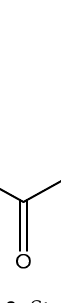
Figure 4. An illustration of the magnesium bis -orotate octahydrate reported by Schmidbaur et al. [84]. The pictorial representation is devoid of the two additional outer-sphere waters reported. As illustrated, the complexed orotic acid does not coordinate to magnesium as a traditional chelate. In fact, the orotic acid forms a complex with magnesium via outer-sphere coordination as a result of an extensive hydrogen bonding network—most notably, the interaction between the deprotonated terminal carboxylic acid and the ubiquitous hexaaquo magnesium core described by Weston [40]. Schmidbaur goes on to elaborate that there was no evidence to support that orotic acid would replace water within the inner sphere of the magnesium and subsequently stated that magnesium bis- orotate tetrahydrate, if bought commercially, would form the described octahydrate in aqueous solution at ambient temperature [84]. Similar findings were produced by Schmidbaur after the synthesis of magnesium bis- anthranalite dehydrate [89]. Schmidbaur further spoke to a similar form of outer-sphere coordination exhibited by citric acid as was initially described by Johnson et al. [90]. Schmidbaur went on to further evaluate the coordination of mandelic acid (mandelate— International Union of Pure and Applied Chemistry (IUPAC): hydroxyl (phenyl) acetic acid), a similar aromatic organic compound (Figure 5) [86,87] to magnesium. Given the structural similarities between orotic acid and mandelic acid, coordinative similarities are to be expected. However, there are four distinct differences between the two acids; the carboxylic acid side chain of mandelic acid is one carbon longer than that of orotic acid and contains a subsequent hydroxyl group, and the benzyl moiety of mandelic acid is devoid of any amines or carbonyls (structure at left). Given the structure of mandelic acid, it is assumed that a magnesium complex formed with such a ligand would form a five-member ring structure and would require two mandelic acid ligands for charge balance as the magnesium is divalent and the mandelic acid ligand is only monoanionic. These assumptions coincide with the findings reported by Schmidbaur et al. (Figure 6) [91]